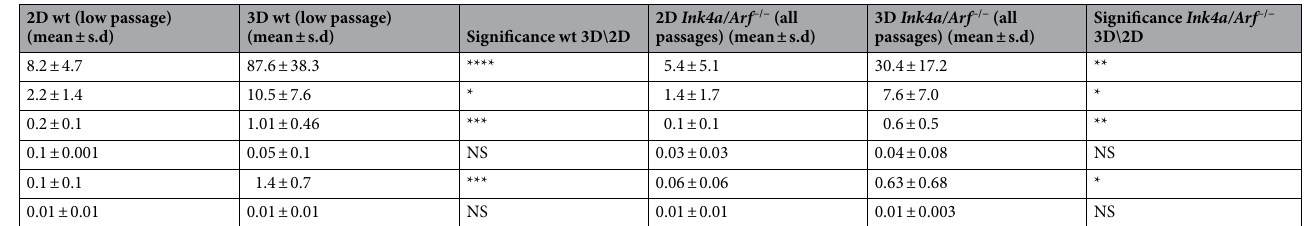
Table 2. qPCR analysis of tendon markers expression in wild-type (wt) and Ink4a/Arf − / − tenocytes in 2D and 3D culture. Values are shown as mean ± s.d. normalized mRNA levels. 3D tendon-like constructs and 2D monolayer culture were compared for each cell type using a t-test, and the p -value is shown for each comparison. For the Ink4a/Arf − / − tenocytes, cells from low, intermediate, and high passage were combined. Significance between 3 and 2D as follows- * p -value < 0.05, ** p -value < 0.01, *** p -value < 0.001, **** p -value < 0.0001. NS not significant.